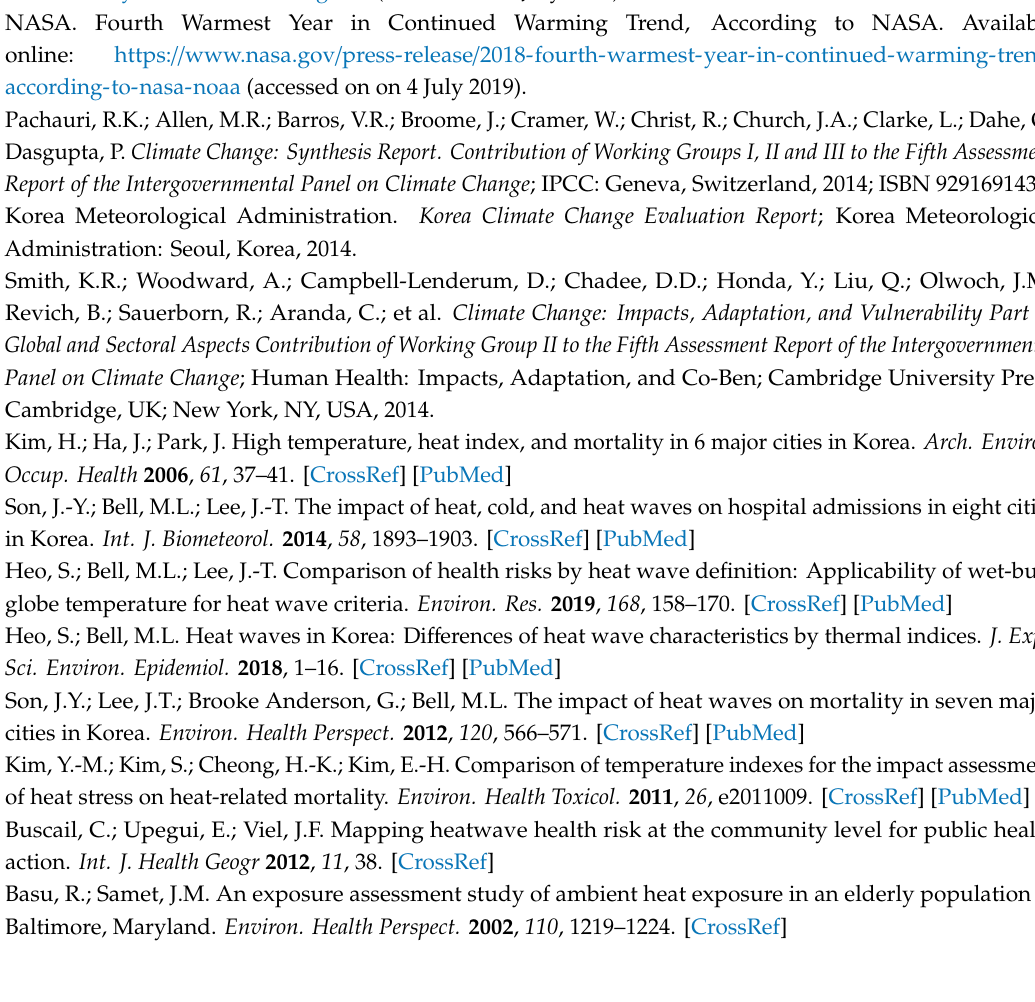
Figure S2: Flow chart of the statistical methods, Table S1: E ff ects of the heat wave warning system on all-cause mortality per 1,000,000 people per day (2009–2014), Table S2: Percentages of false positive and false negative heat wave days by city and year, Table S3: Estimated e ff ects of the heat wave warning system on cardiovascular and respiratory deaths per 1,000,000 population per day, based on propensity score weights truncated at the 99 percentile, Table S4: E ff ects of e ff ects of the heat wave warning system on mortality in di ff erent age groups of children and adolescents